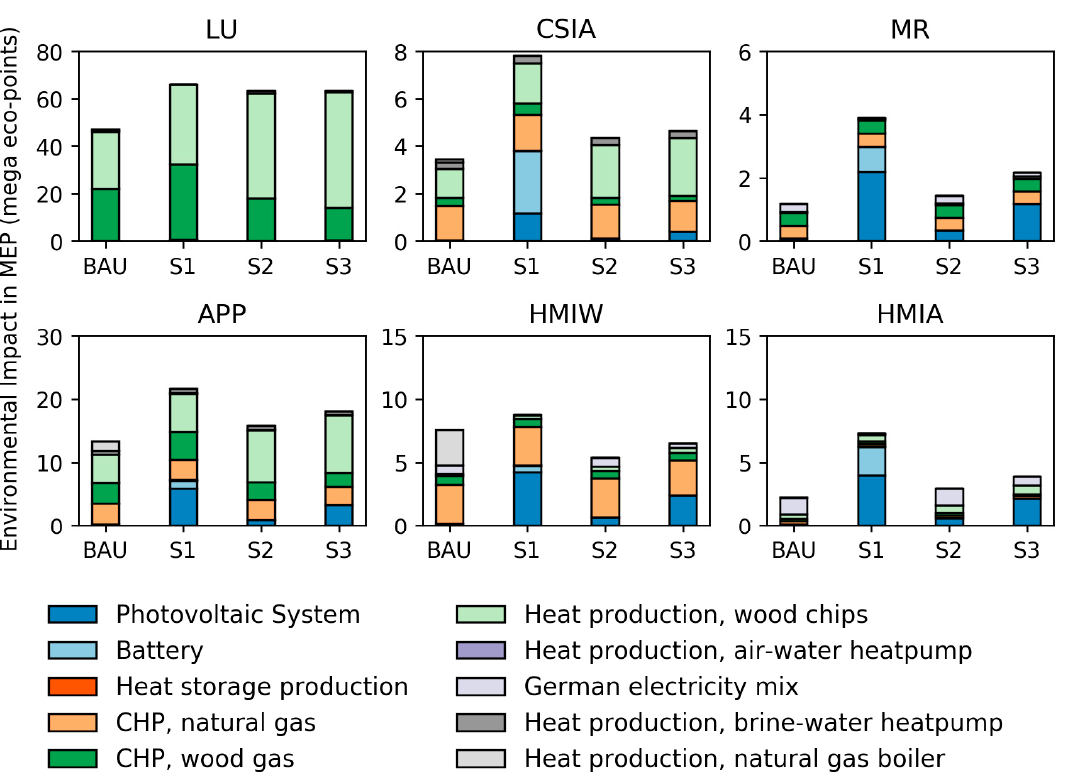
Figure 6. Share of energy carriers and storage technology for several impact categories, LU = land use, CSIA = carcinogenic substances into air, MR = mineral resources, APP = main air pollutants and PM HMIW = heavy metals into water, HMIA = heavy metals into air.